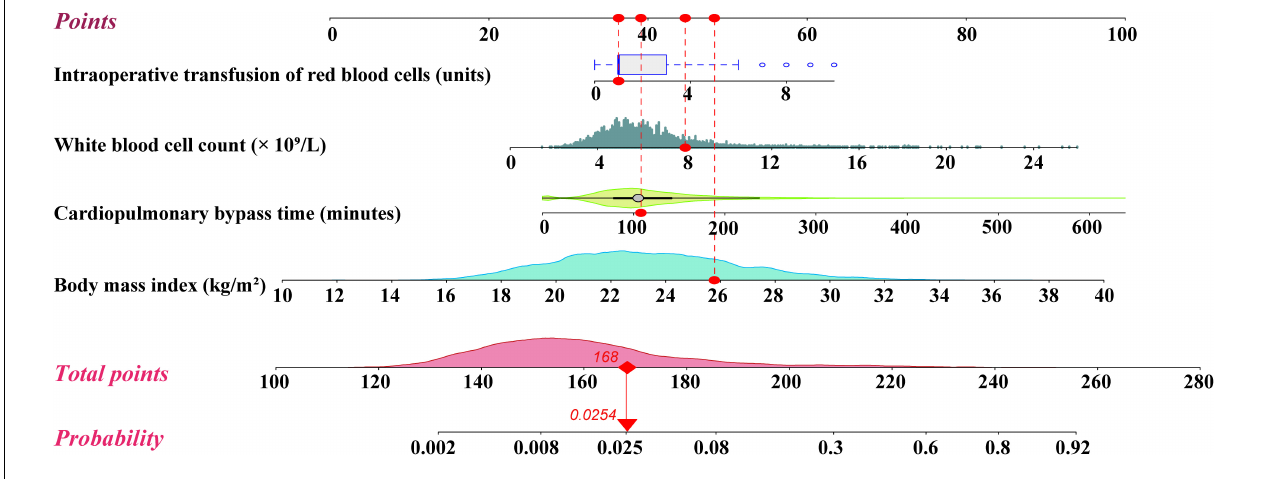
goodness-of-fit test χ 2 -value P -value